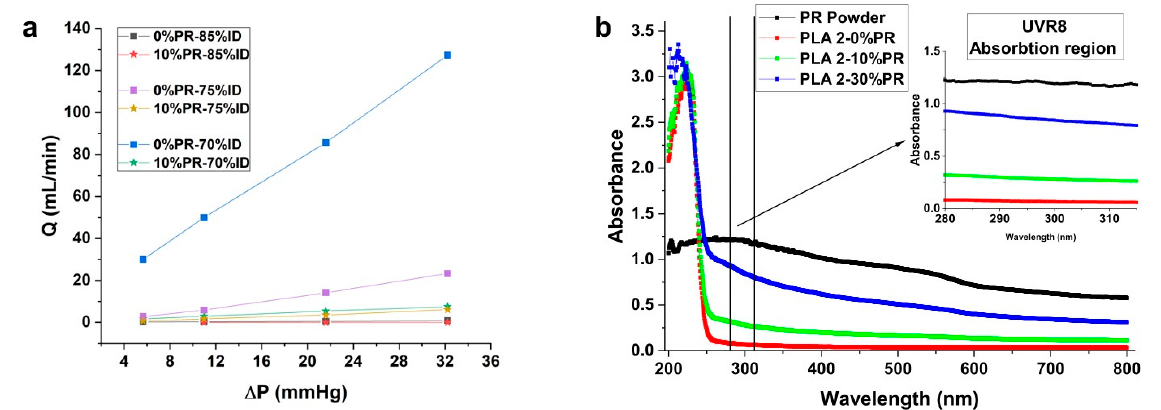
Figure 6. Volumetric water flow as a function of the pressure gradient applied along the permeable part of the self-watering pot ( a ), UV–Vis absorbance spectra of the printed film at different percentages of PPW ( b ).